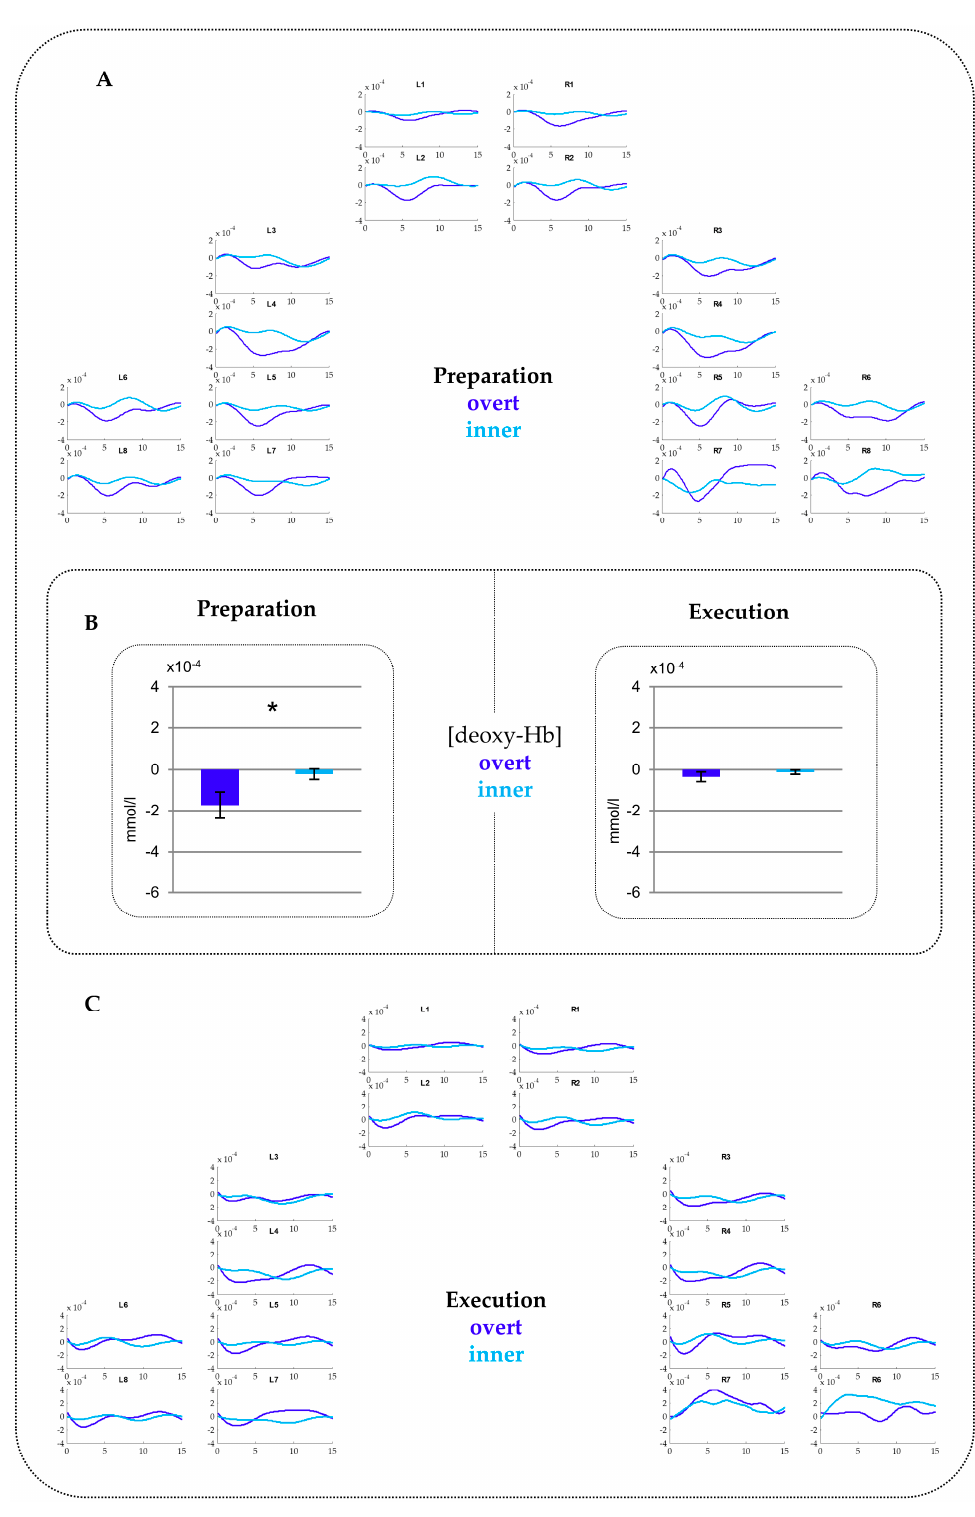
Figure 3. fNIRS results for (deoxy-Hb). ( A ) Time courses for the Preparation phase. ( B ) Beta-values comparing overt and inner speech for the Preparation phase (left) and Execution phase (right) merged overallROIs. Theasteriskindicatesstatisticallysignificantdi ff erencesbetweenovertversusinnerspeech. Please note that a more negative value for (deoxy-Hb) indicates increased activations. ( C ) Time courses for the Execution phase. See Appendix A Figure A3 for time courses for the Preparation and Execution phase in (deoxy-Hb) including standard errors of the mean